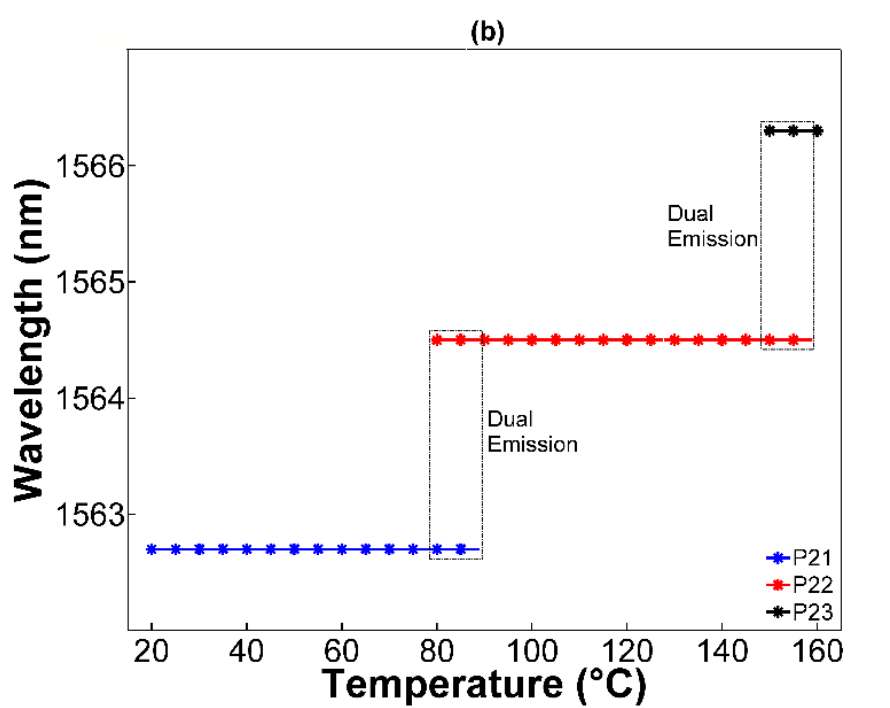
Figure 6. Switchable operation of the EDFL using MZI 2 and MZI 1b in a cascade configuration, withstanding temperature variations between 20 to 160 °C. ( a ) Laser emissions and ( b ) stability analysis of laser emissions against temperature changes. Table 3. Summarized results of the MZI 2 connected and cascaded with MZI 1 .